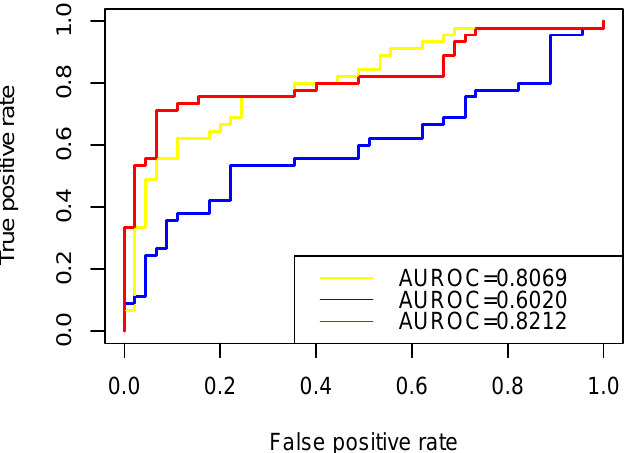
Figure 4. The prediction performance for prioritizing colon cancer causal RNAs. The ROC curves illustrating the performance in distinguishing “related” label RNAs from “irrelevant” label RNAs. Red curve represented RW-DIR; the blue curve represented TRWR, which was directly used on the basis of the heterogeneous network that is constructed in this study; the yellow curve represented RW-DIR without